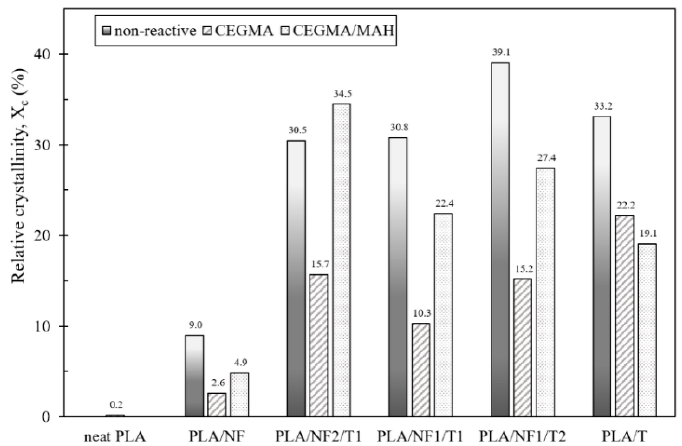
Figure 8. Degree of crystallinity ( X c ) of PLA hybrid composites at different filler ratios, with and without various reactive compatibilizers.